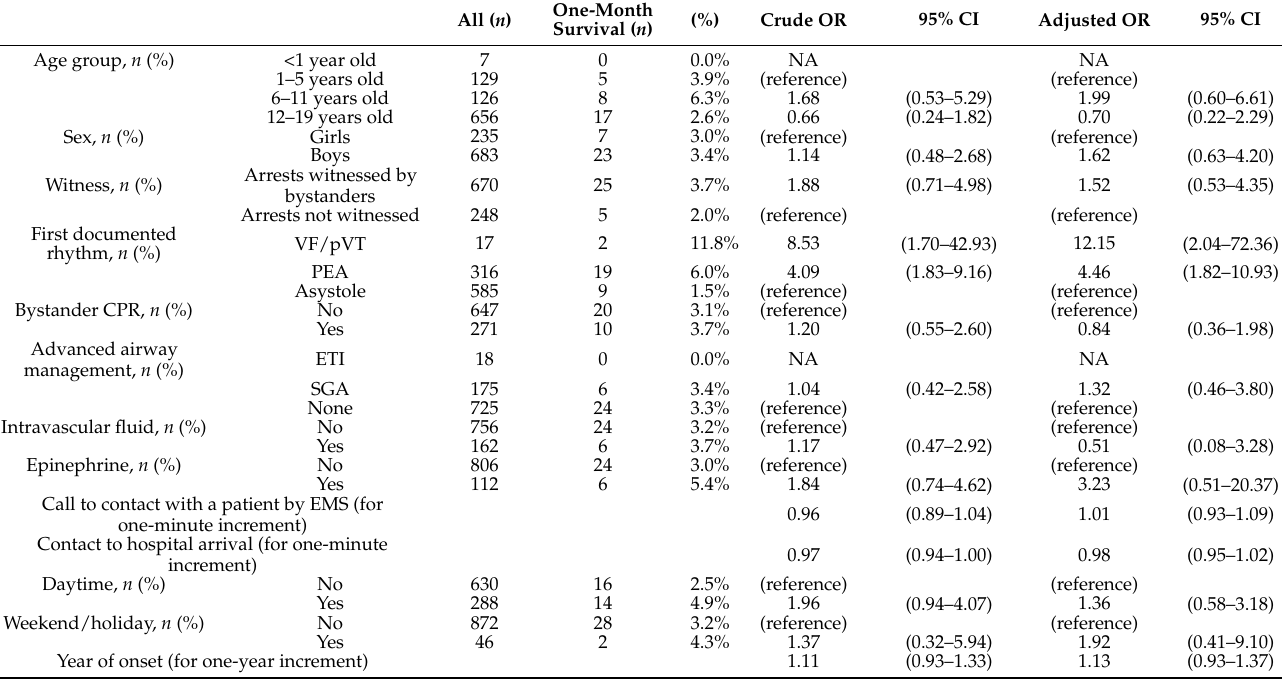
Table 3. Factors associated with one-month survival.